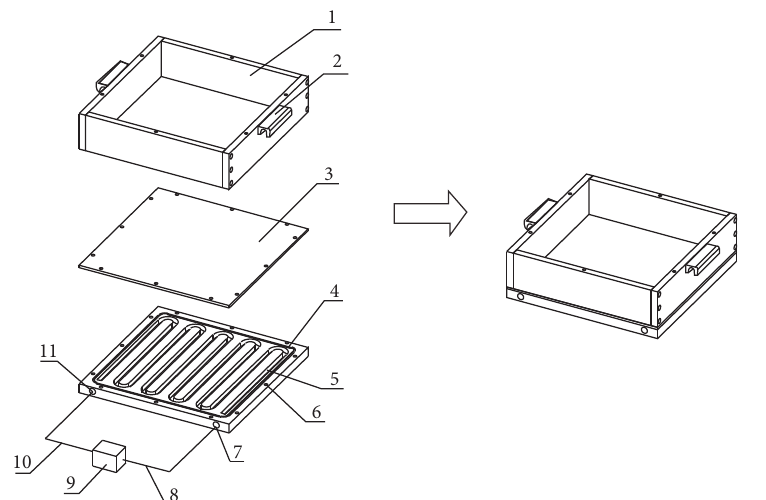
Figure 2: Schematic diagram of test mold for specimen bottom constant temperature controlling; 1: side plate; 2: handle; 3: sealing cover plate; 4: sealing ring; 5: constant temperature water channel; 6: fixed hole; 7: outlet; 8: outlet pipe; 9: thermostat; 10: water inlet pipe; and 11: water inlet.